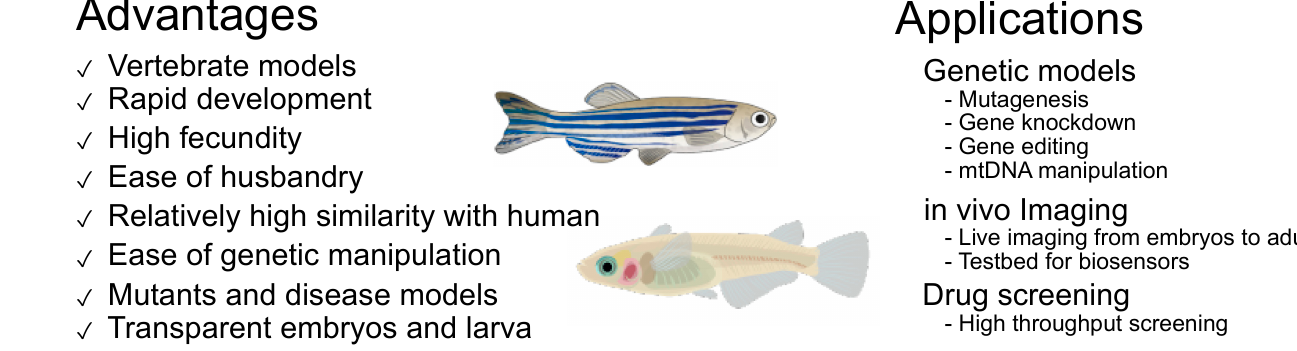
Figure 3. Advantages and applications of small fish models.